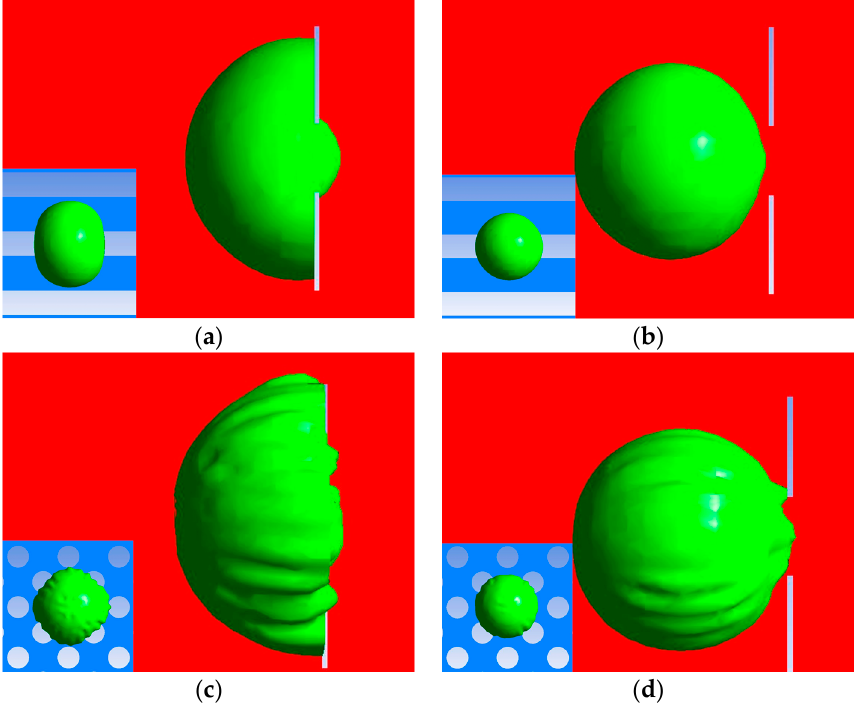
Figure 5. Circulating tumor cells (CTCs) captured in the microfilters at an inlet velocity of 75 mm/s: ( a ) CTCs captured in the slit-shaped pores with a contact angle of 90°; ( b ) CTCs captured in the slit- ( a ) CTCs captured in the slit-shaped pores with a contact angle of 90 ◦ ; ( b ) CTCs captured in the shaped pores with a contact angle of 180°; ( c ) CTCs captured in the circular pores with a contact angle slit-shaped pores with a contact angle of 180 ◦ ; ( c ) CTCs captured in the circular pores with a contact of 90°; ( d ) CTCs captured in the circular pores with a contact angle of 180°. angle of 90 ◦ ; ( d ) CTCs captured in the circular pores with a contact angle of 180 ◦